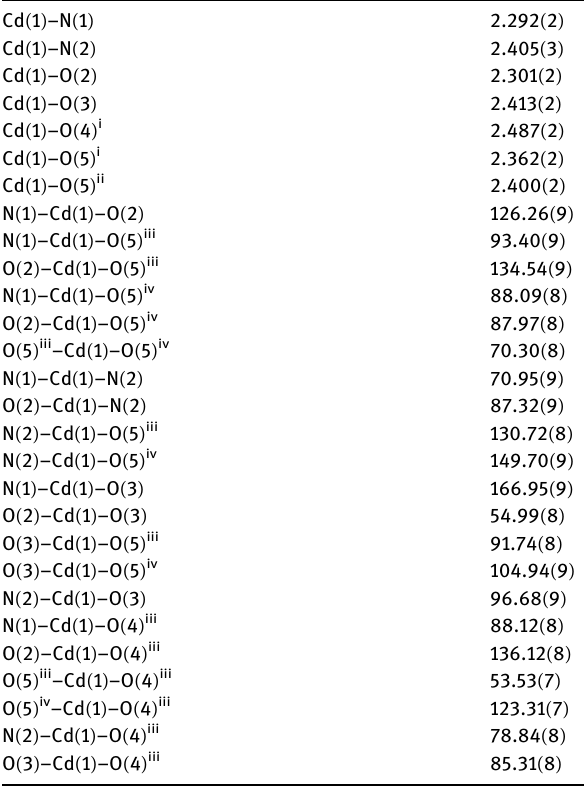
Table 3: Selected bond lengths ( Å ) and angles ( ° ) for the complex